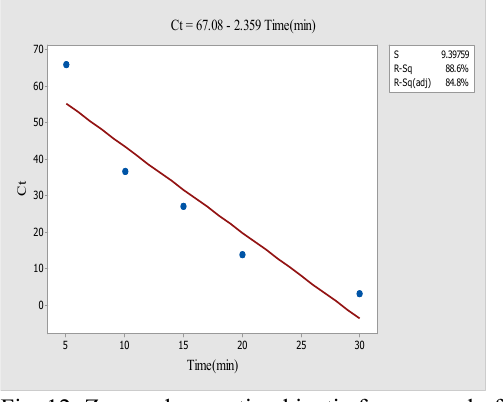
Fig. 12. Zero order reaction kinetic for removal of acid blue 113 dye